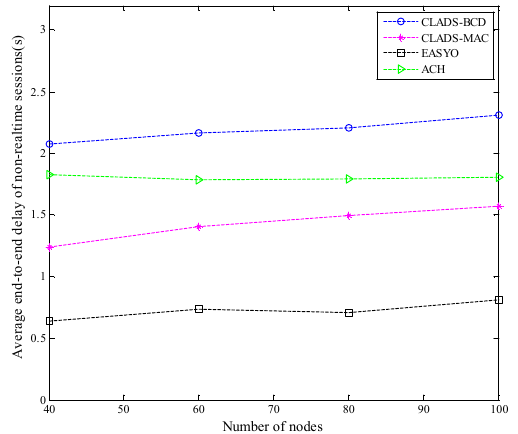
Figure 8. Average end-to-end delay of non-real-time sessions under different numbers of